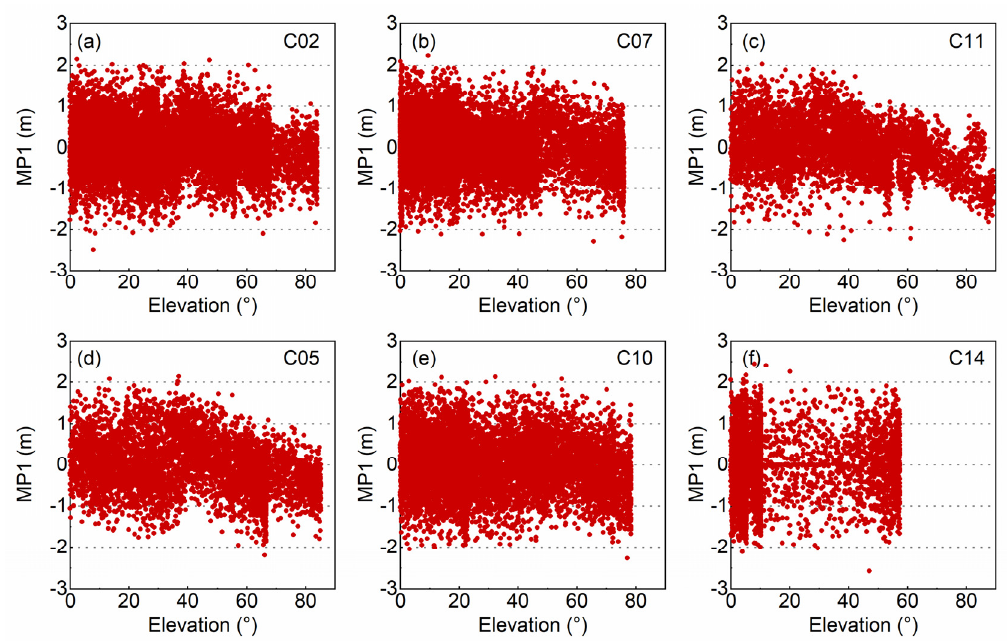
Figure 5. The relationship between multipath and antenna elevation angle for di ff erent BDS satellites: ( a ) C02, ( b ) C07, ( c ) C11, ( d ) C05, ( e ) C10, ( f )